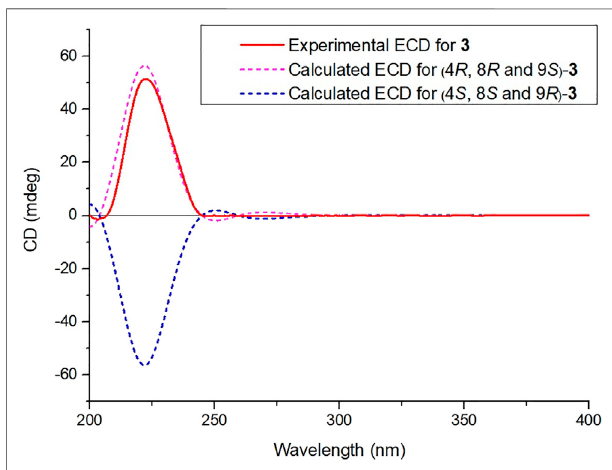
FIGURE 4 | Calculated and experimental ECD spectra of compound 3